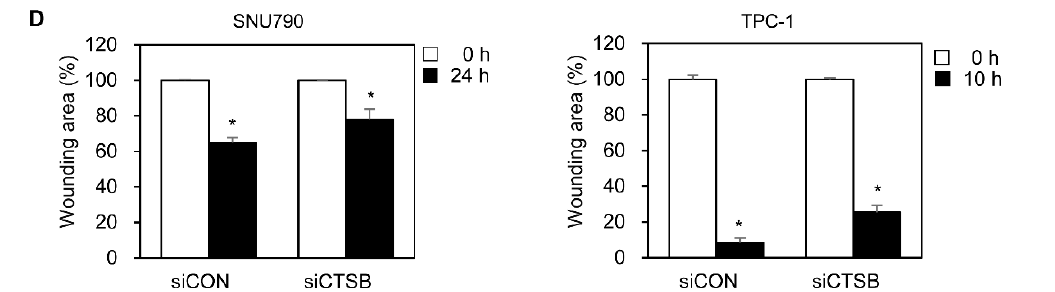
Figure 4. Knock down of CTSB expression inhibits activation of cell migration in PTC cell lines. ( A , B ) Immunoblotting for CTSB, Snail, and vimentin after transfection with siCON or siCTSB in SNU790 and TPC-1 cells for 24 h. Table for the relative levels of Snail or vimentin in the knock down of CTSB. The band intensity of Snail or vimentin was calculated using ImageJ program and normalized to that of the band intensity of β -actin. The relative level of Snail or vimentin was calculated and statistically analyzed. ( C ) Wound healing assay in SNU790 and TPC-1 after transfection with siCON or siCTSB. ( D ) The wounding area (%) of SNU790 (24 h) or TPC-1 (10 h) cells with the treatment of siCON or siCTSB. The number of the relative migrating cells or wounding area was analyzed using ImageJ in SUN790 cells at 24 h and in TPC-1 cells at 10 h. Band intensity was normalized to β -actin expression and quantified using ImageJ. Data are representative of three independent experiments. * p <